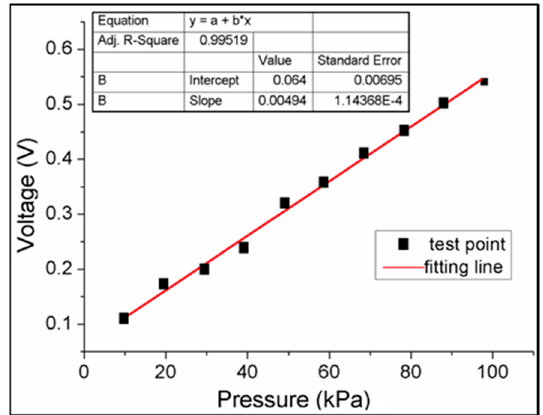
8 of 20 Figure 5. Data acquisition system. Figure 6. The calibration diagrams of each cell of the matrix soft sensor. In the calibration, the counterweights were put on each sensor cell one by one in a designed sequence, and the corresponding voltage signals were collected using the developed data acquisition system as aforementioned. Through calibration, a series of counterweights and their corresponding signals were recorded. The relationship between the produced voltages (V) and the pressure (kPa)